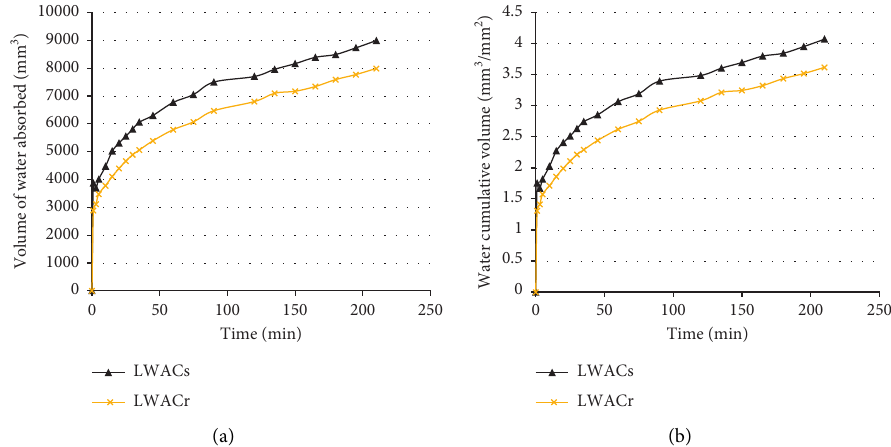
Figure 10: (a) Volume of water absorbed in LWAC mixes versus time and (b) evolution in the cumulative volume of water absorbed in LWAC mixes with time.